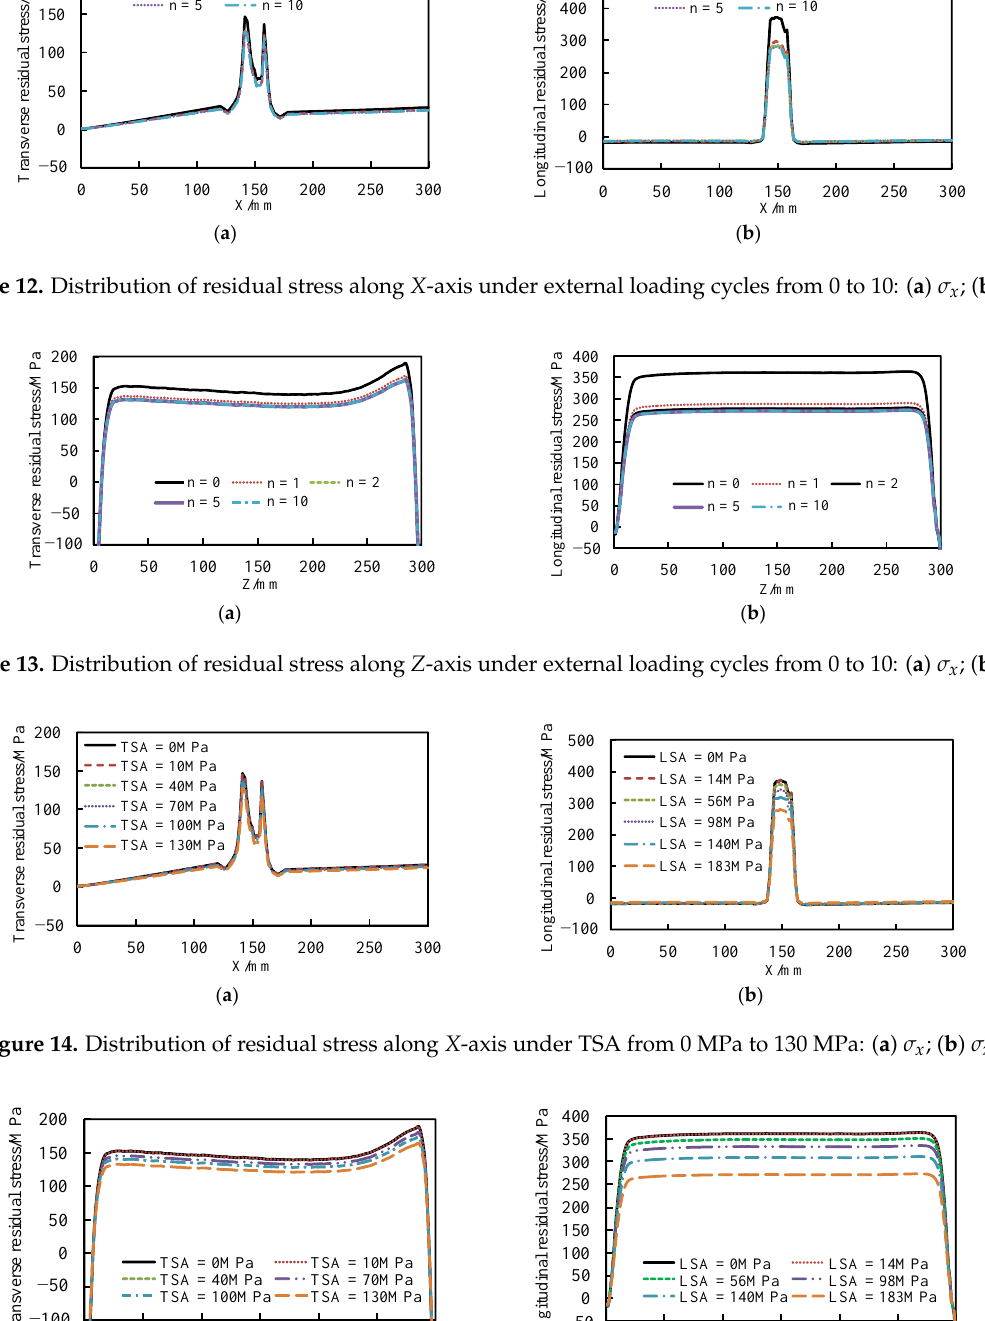
Figure 15. Distribution of residual stress along Z -axis under TSA from 0 MPa to 130 MPa: ( a ) σ